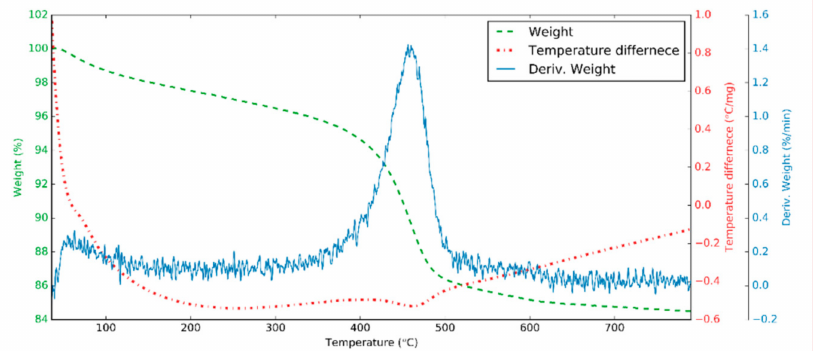
Figure 5. Thermogravimetry / di ff erent thermal analysis curve for